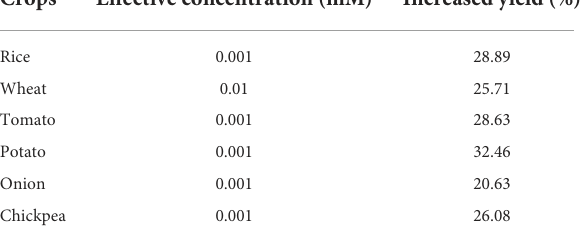
TABLE 5 Most effective concentration of calliterpenone in various crops.